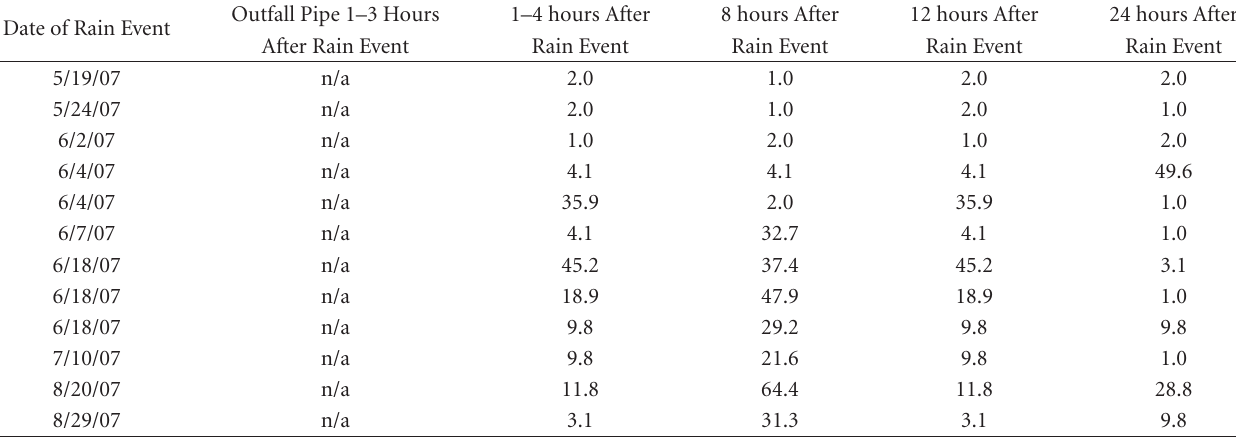
Table 9: E. coli concentrations ( ∗ MPN/100mL) from beach water collected at time intervals following the triggering of a rain event at Whitefish Dunes State Park beach. There was no significant di ff erent between overall E. coli concentrations during a rain event and the seasonal mean E. coli concentrations for this beach using ANOVA (Table 1). Likewise, using Sche ff e matrix analysis, there was no significant di ff erence between E. coli concentrations at any sampling times after a rain event and the seasonal E. coli mean. If rainfall was su ffi cient to trigger multiple rain event notifications on one day, then multiple events were